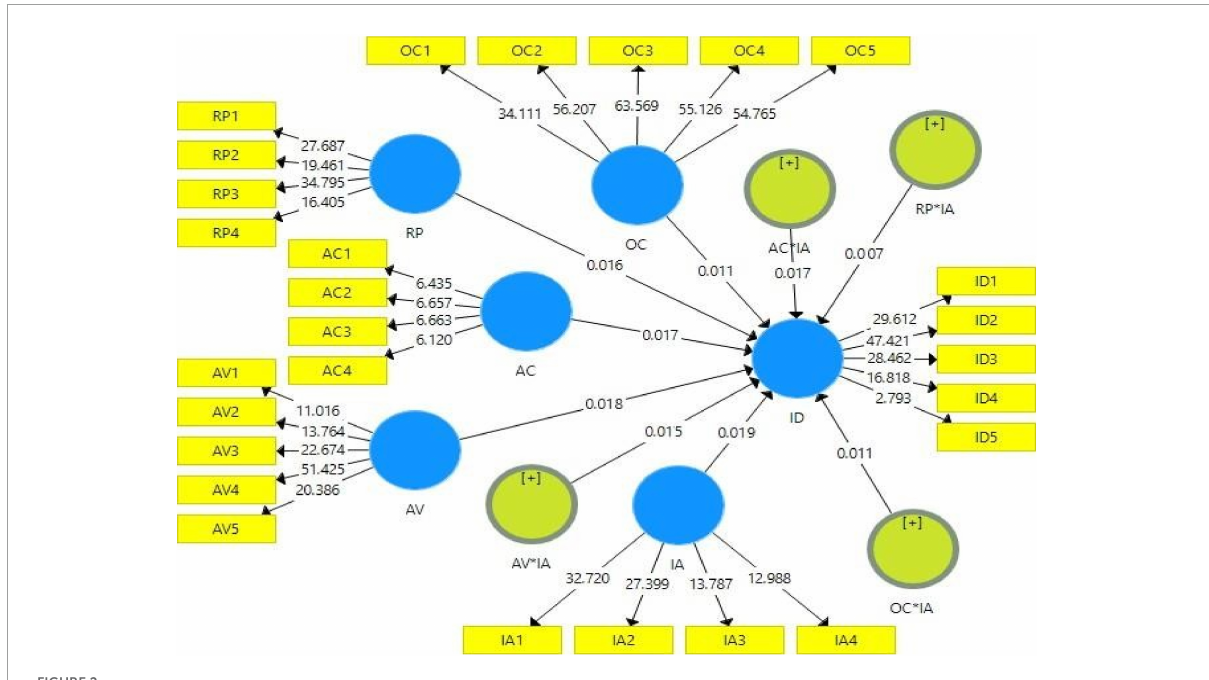
FIGURE2 Structural model assessment.